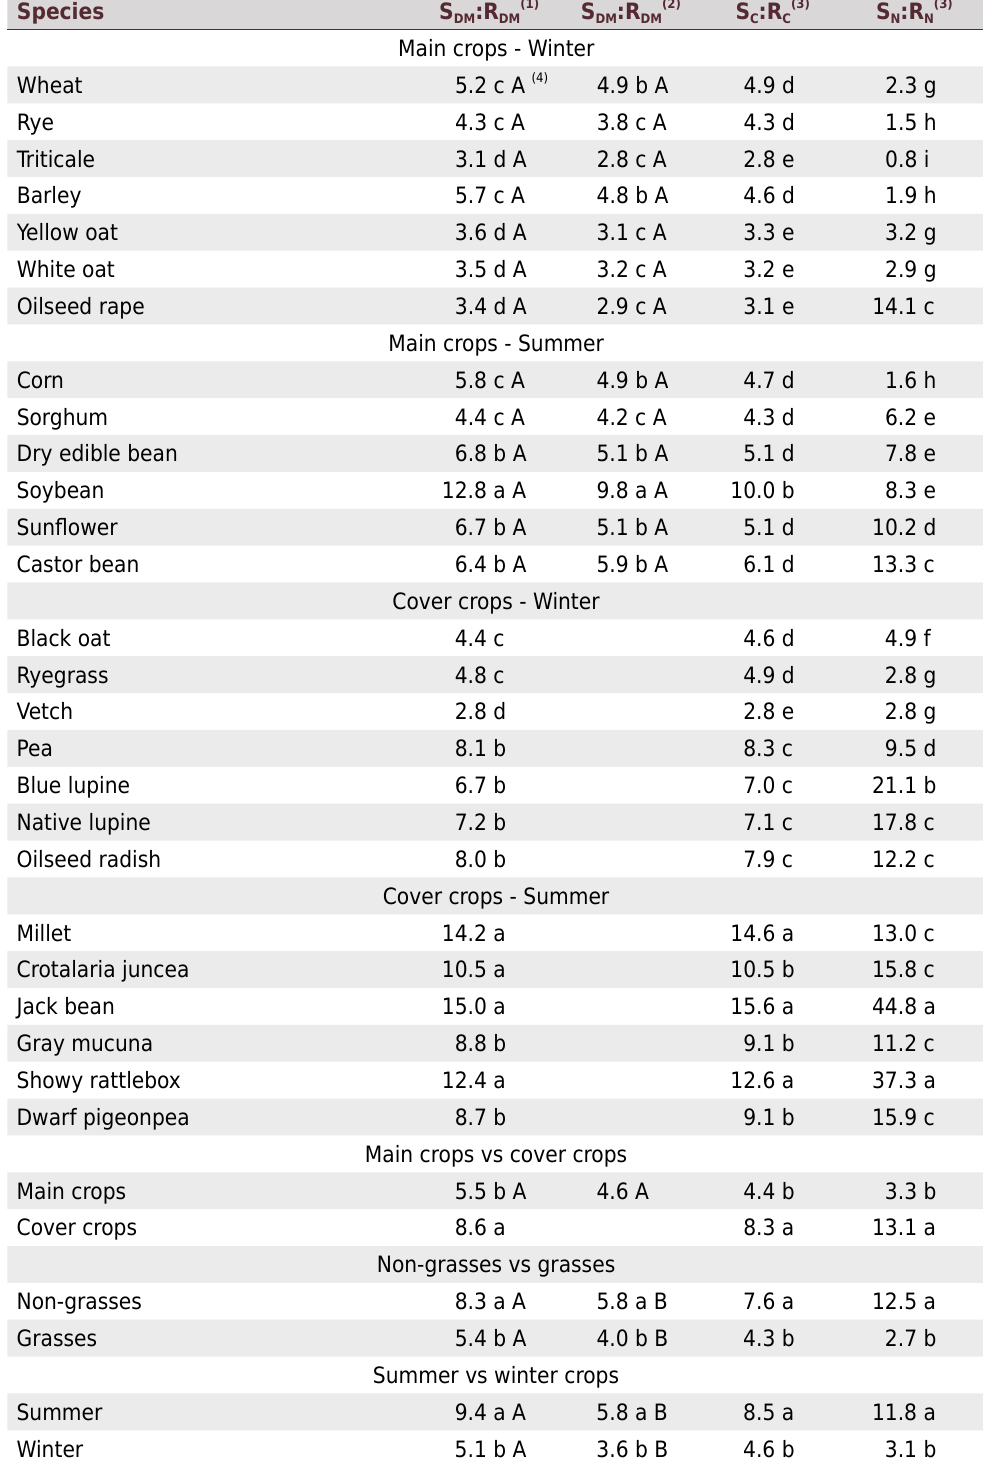
Table 4. Shoot:root ratios (S:R) calculated for total dry matter (DM), C, and N contents of main crops and cover crops sampled at flowering or maturity